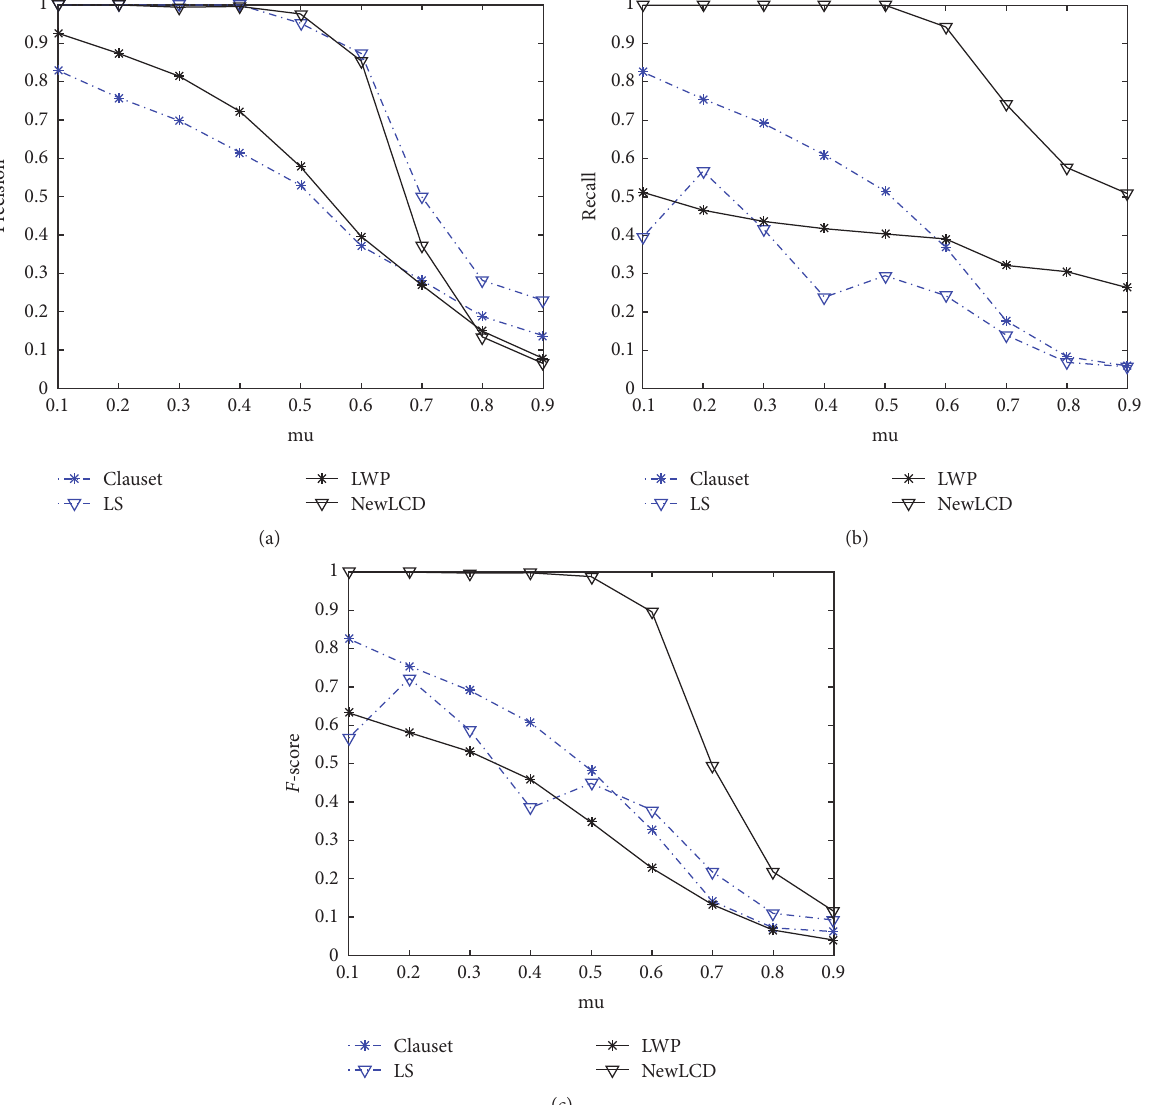
Figure 3: Comparison of